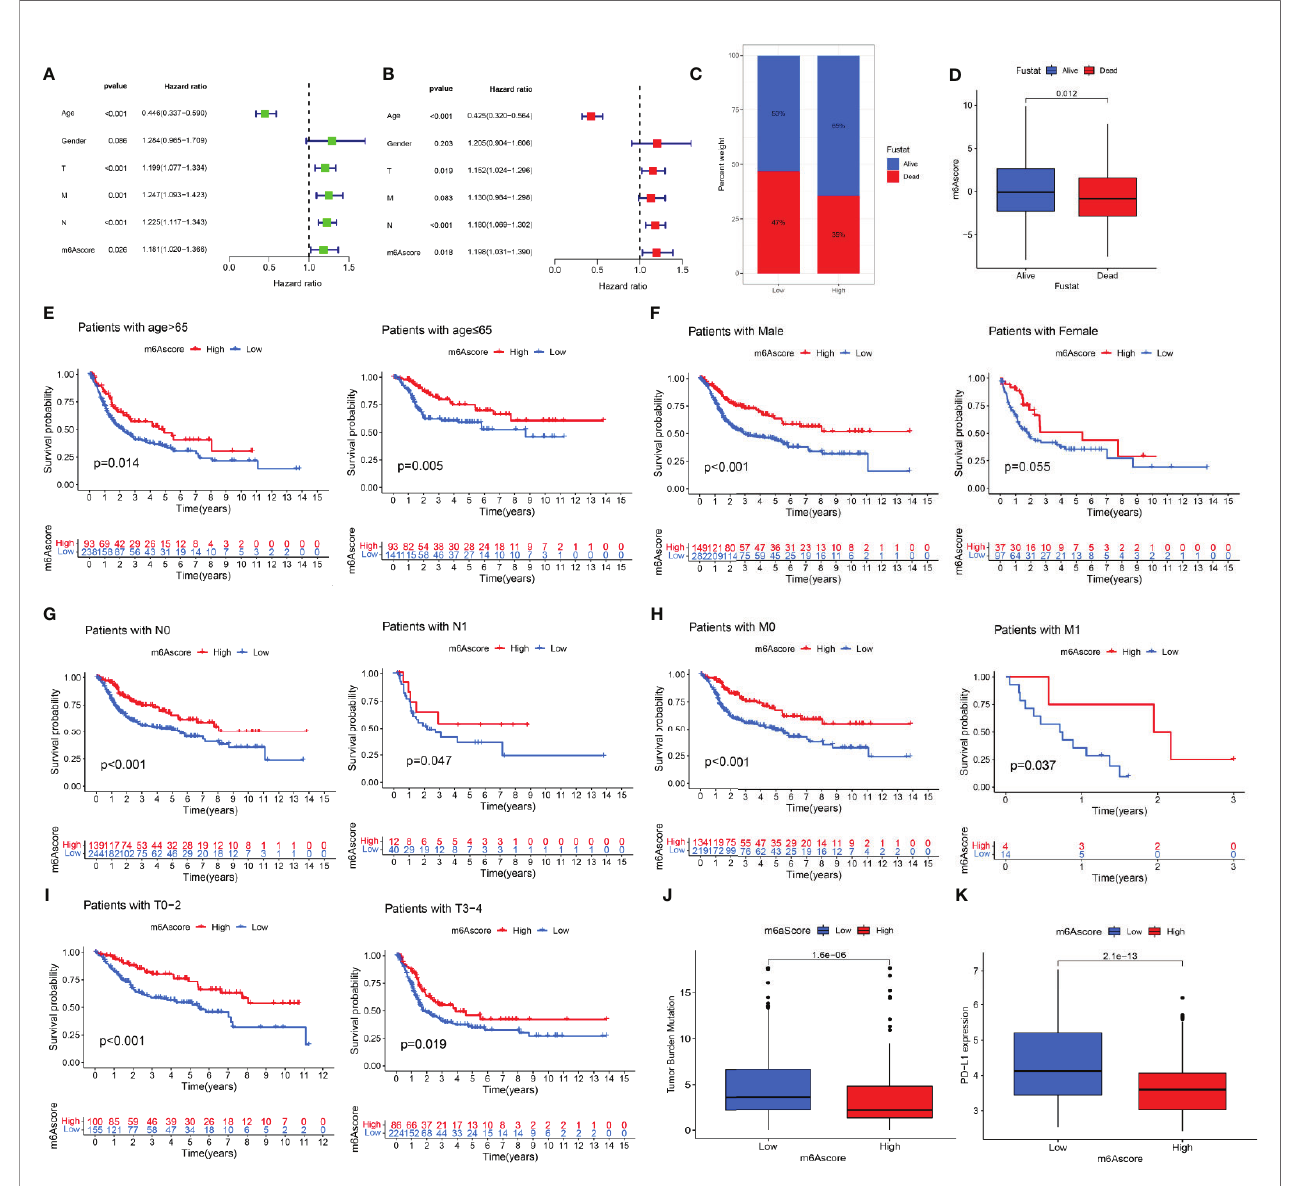
FIGURE 6 | The prognostic value of the m6A score and the correlation between the clinicopathological features and m6A score. (A) Univariate Cox regression analysis of the m6 score for bladder cancer was shown by forest plot. (B) Multivariate Cox regression analysis of m6 score for bladder cancer was shown by forest plot. (C) Strati fi ed analysis of the m6A score for bladder cancer patients by status. (D) Strati fi ed analysis of the m6A score for bladder cancer patients by status. (E) Strati fi ed analysis of the m6A score for bladder cancer patients by age. (F) Strati fi ed analysis of the m6A score for bladder cancer patients by gender. (G) Strati fi ed analysis of the m6A score for bladder cancer patients by N. (H) Strati fi ed analysis of the m6A score for bladder cancer patients by M. (I) Strati fi ed analysis of the m6A score for bladder cancer patients by T. (J) Strati fi ed analysis of the m6A score for bladder cancer patients by tumor mutation burden. (K) Strati fi ed analysis of the m6A score for bladder cancer patients by